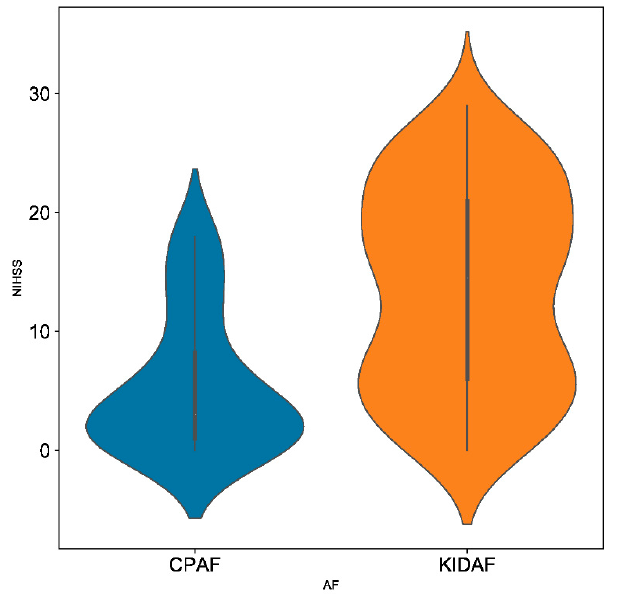
Figure 3. Violin representation of clinical stroke severity (NIHSS) according to CPAF and KIDAF patients.